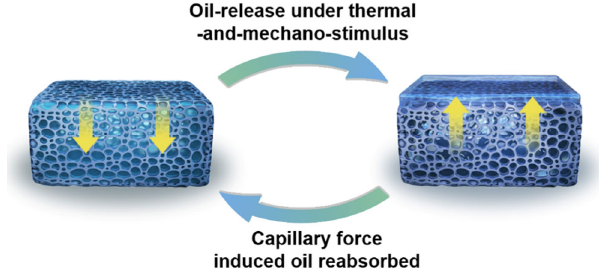
Fig. 14 Schematic diagram of recyclable lubricant release/ reabsorption of hierarchically porous oil-containing polyimide.